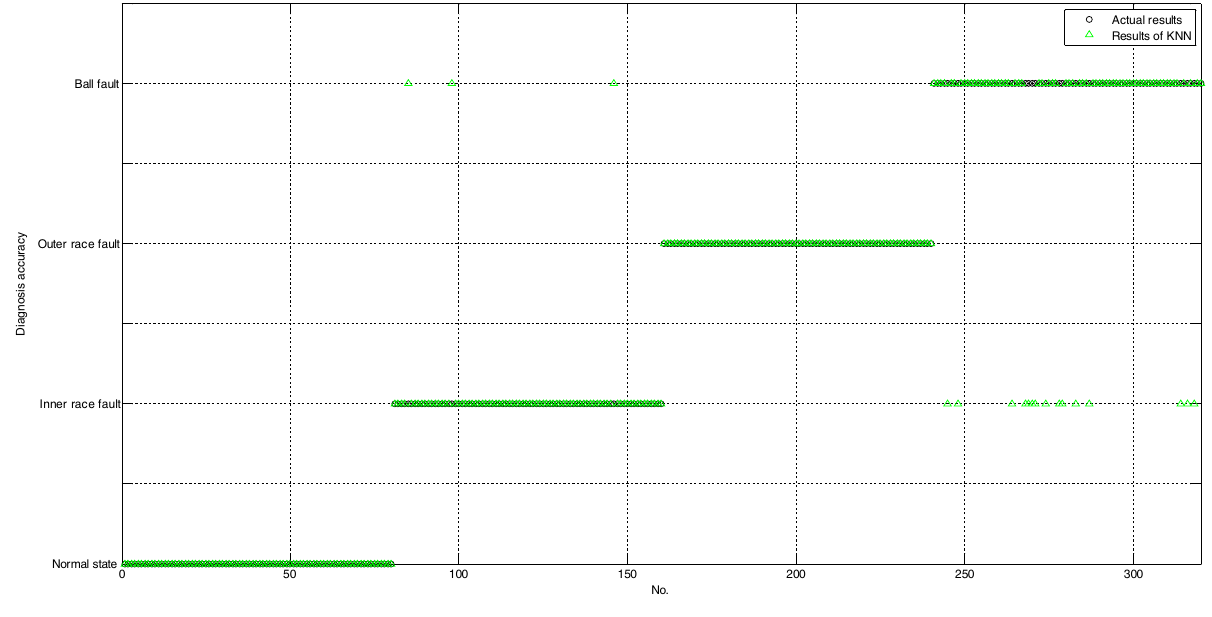
Figure 6. The diagnosis results of bearing based on KNN. Diagnosis